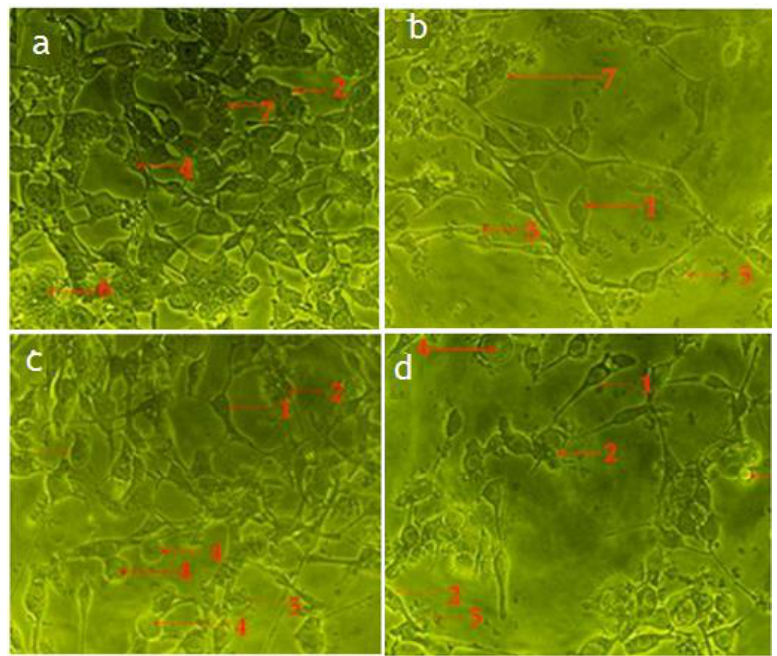
Figure 5. Photomicrograph showing the morphological changes of RMS cells. RMS cells treated with hexane fraction of C. minima —( a ): 37.5μg/mL; ( b ): 75 μg/mL); and chloroform fraction of C. minima ( c ): 45 μg/mL; ( d ): 90 μg/mL) for 24 h and imaged with a phase-contrast microscope (magnification 200×).